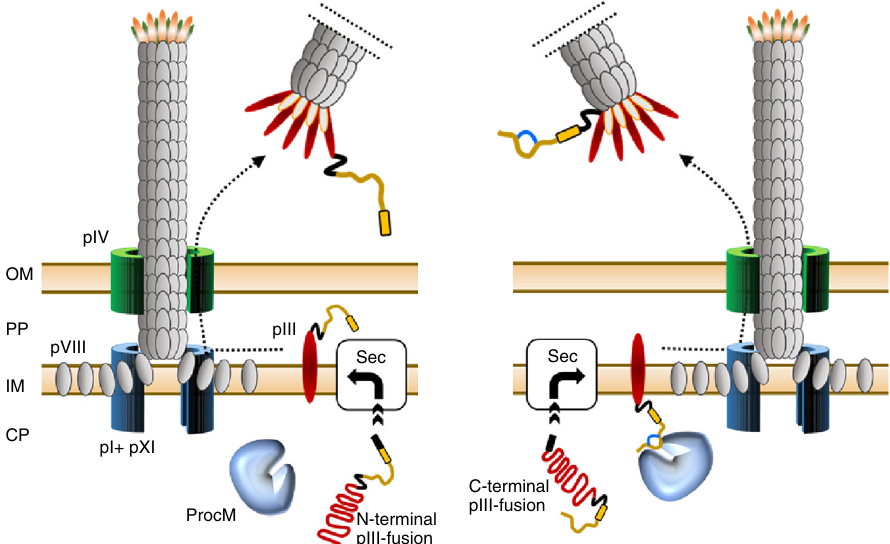
Fig. 5 Display of lanthipeptide precursors on the N- and C-termini of phage pIII. N-terminal pIII display of largely unmodi fi ed lanthipeptide precursors (left panel). Translocation of unstructured peptide – pIII fusions from the cytoplasm (CP) via the Sec pathway (Sec) is fast allowing little or no lanthionine introduction by ProcM, whereas modi fi ed lanthipeptides are poorly transported via the narrow Sec pore. Prior to phage assembly, the precursor peptide (ocher) is exposed to the periplasm (PP) and no longer accessible to ProcM. C-terminal display of lanthipeptides (right panel). After translocation of the pIII – peptide fusion, the C-terminal exposed peptide remains in the cytoplasm allowing ProcM-catalyzed lanthionine introduction (indicated by a blue cycle). Phage display of modi fi ed peptide is accomplished after incorporation of pIII into the phage coat and subsequent extrusion of the phage particle into the medium. Black arrows indicate movement of capsid proteins to the phage assembly site. OmpA signal sequence in pIII fusions (black box), leader peptide (yellow box), linker sequences (black line), relevant phage coat proteins (as numbered), outer membrane (OM), and inner membrane (IM) are